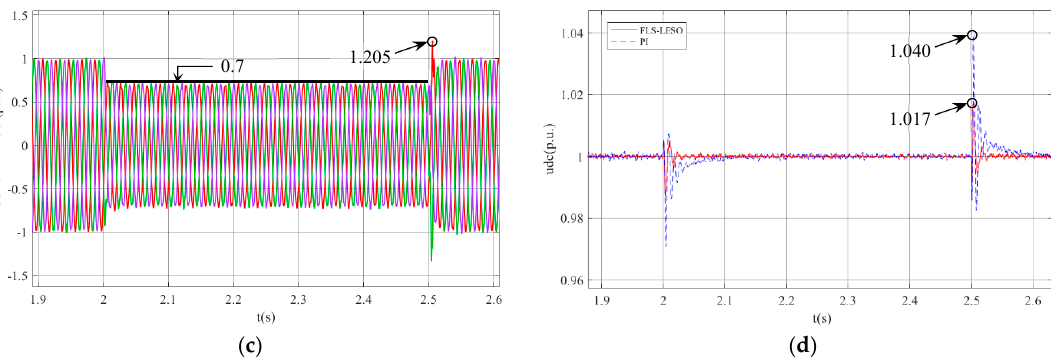
Figure 15. ( a–d ). Dynamic response of a 1.5 MW permanent magnet synchronous generator (PMSG) with the traditional PI controller and fuzzy logic system with linear extended state observer (FLS-LESO) during the 30% decrease in wind turbine power; ( a ) Voltage at PCC; ( b ) Current at PCC with the PI controller; ( c ) Current at PCC with the FLS-LESO; ( d ) DC link voltage.